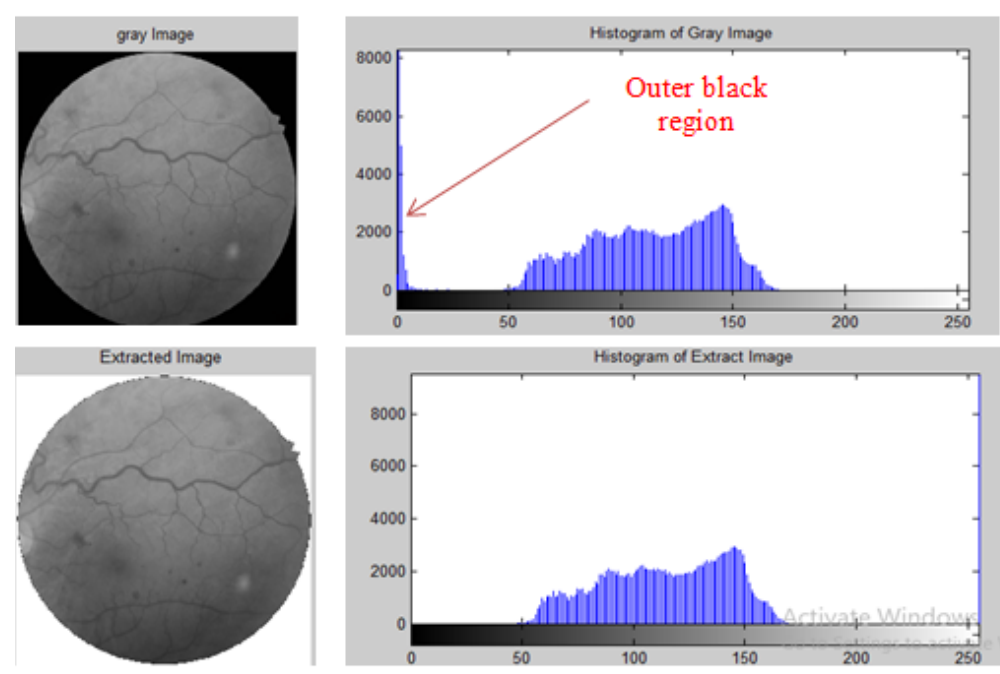
Fig.6: The images and their histograms before and after crop outer black